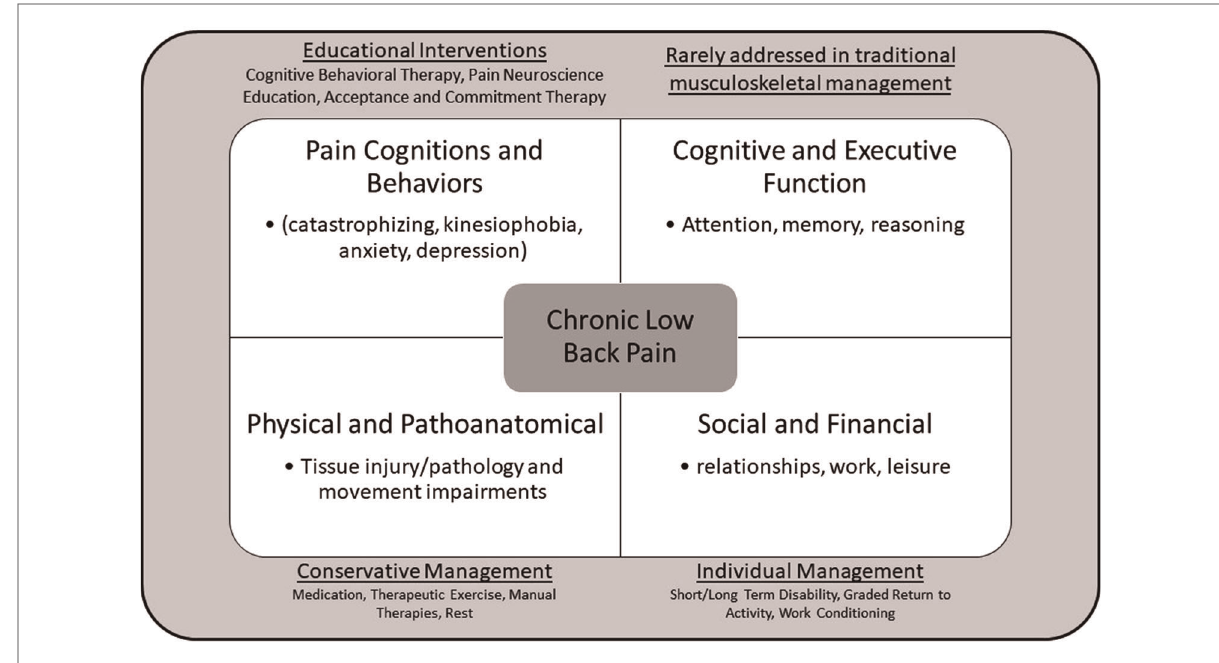
FIGURE 1 Multidimensional nature of chronic low back pain and it ’ s traditional management